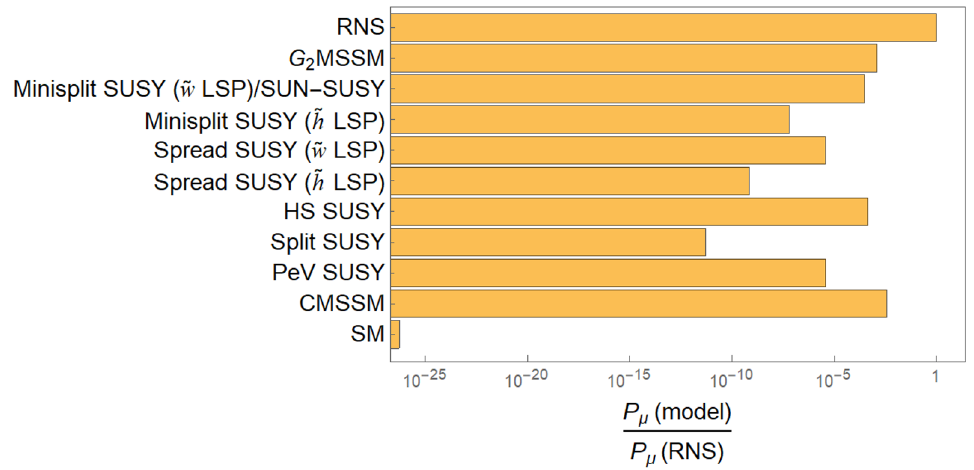
Figure 3 . Values of relative probabilities P µ ( model ) /P µ ( RNS ) for the various benchmark scenarios considered in the